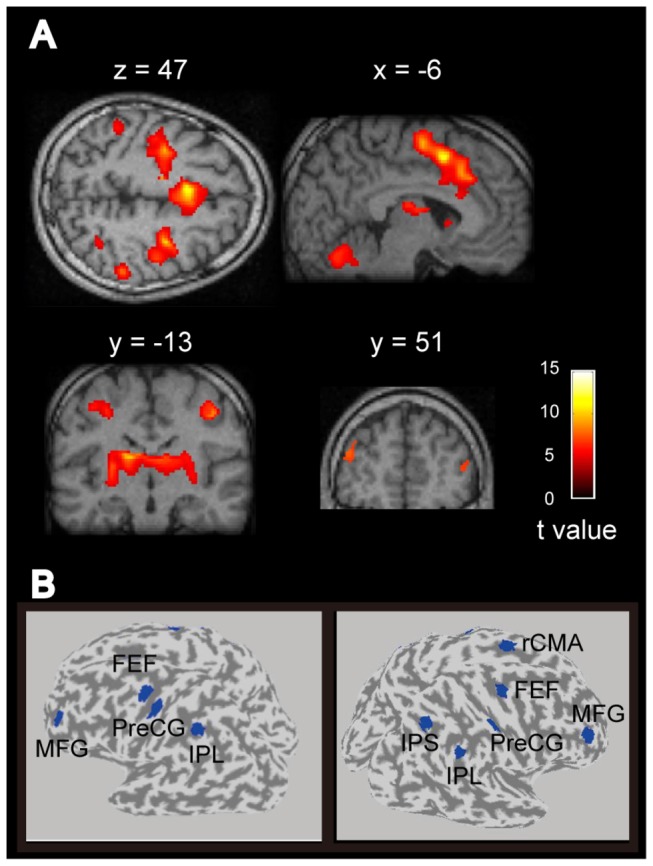
Self-monitoring related activity in fMRI experiments and ROI specification.
A, Brain areas activated more during the observer-control condition than the passive viewing condition (P < 0.001, uncorrected; extended threshold of 30 voxels). B, Ten ROIs were defined by specifying a circular region with a 6-mm radius centered at the coordinates shown in Table 1. Abbreviations are the same as in Table 1.